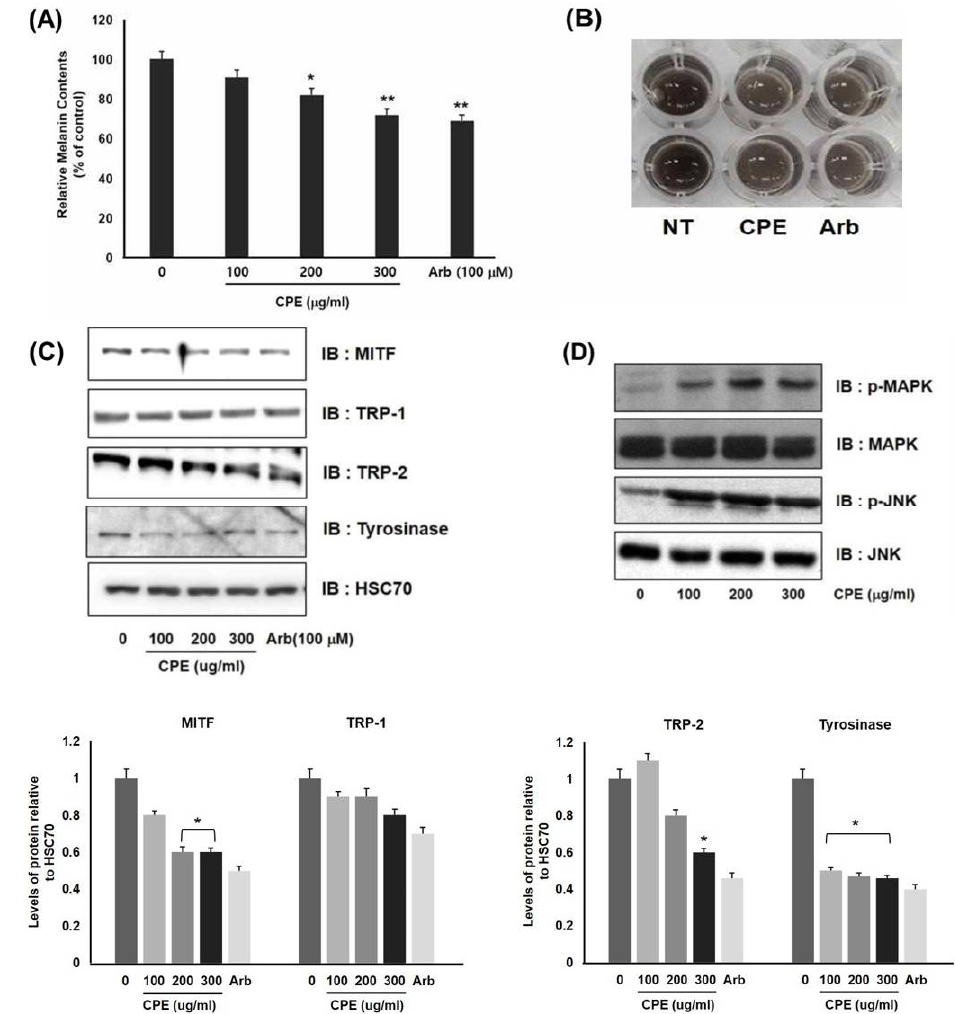
Figure 1. Codonopsis pilosula extract (CPE) decreased melanogenesis by inhibiting the MITF/MAPK pathway in melanocytes. ( A ) Melan-a cells were treated with CPE (100, 200, and 300 μg/mL) and arbutin (100 μM) for 72 h. Then, the melanin content was measured using an ELISA reader. ( B ) The melanin level in Melan-a cells was visualized after dissolving cell pellets in 1 N NaOH. ( C ) The expression of MITF, TRP-1, TRP-2, and tyrosinase, as well as that of ( D ) MAPK and JNK and their phosphorylation, were determined by Western blotting. HSC70 was used as the internal standard. All data are shown as the means ± SDs of at least three independent experiments (* p < 0.05, ** p < 0.01 vs.